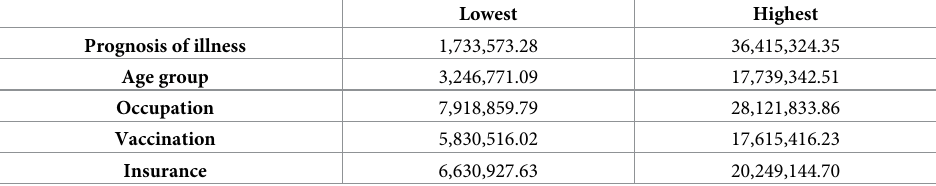
Table 3. The estimated total economic burden (in US$) of JE in Zhejiang Province, 2013–2018, under different extreme situation of corresponding significant risk factor. Lowest